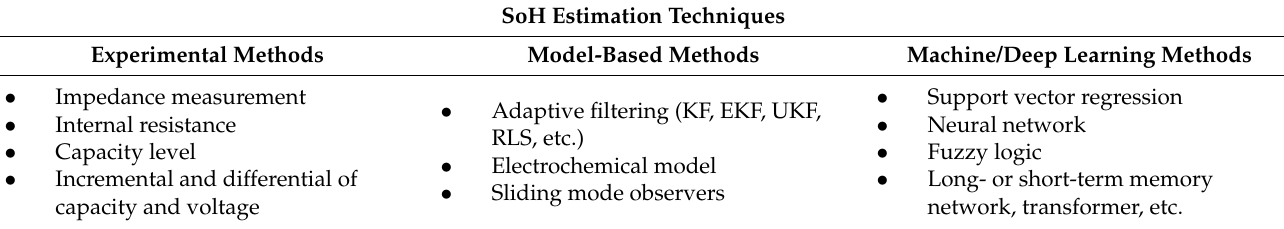
Table 5. SOH estimation